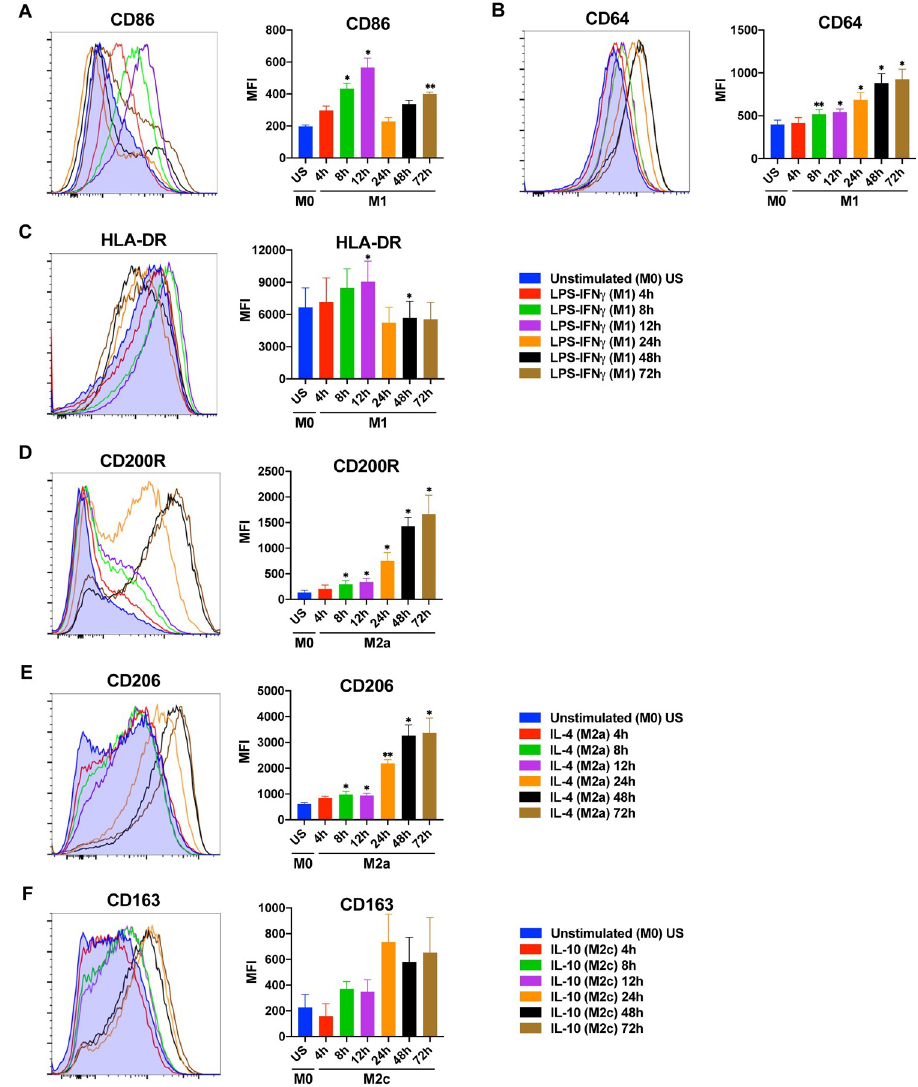
Fig 2. Time depended changes in the expression of macrophage polarization markers at protein level. Primary human MDMs (M0) were left unstimulated or were polarized to M1 (100 ng/mL LPS, 20 ng/mL IFN γ ) or M2a (20 ng/ mL IL-4) for 4, 8, 12, 24, 48, or 72 h. Surface marker expression (A-C) of CD86, CD64 and HLA-DR for M1 polarization; (D-E) of CD200R and CD206 (MRC1) for M2a polarization, and (F) of CD163 for M2c polarization was analyzed by flow cytometry. Shown are representative histograms (left) and summary data shown are mean ± SEM of biological replicates of 3 independent donors (right). Polarized macrophages (M1, M2a, or M2c) at all time points were compared with unstimulated (US) M0 macrophages. Trends for individual donors are depicted in S2 Fig. Statistical analyses were performed with repeated measures ANOVA, � p < 0.05; �� p < 0.01; ��� p < 0.001 (Statistical comparison of all time points are shown in the S2